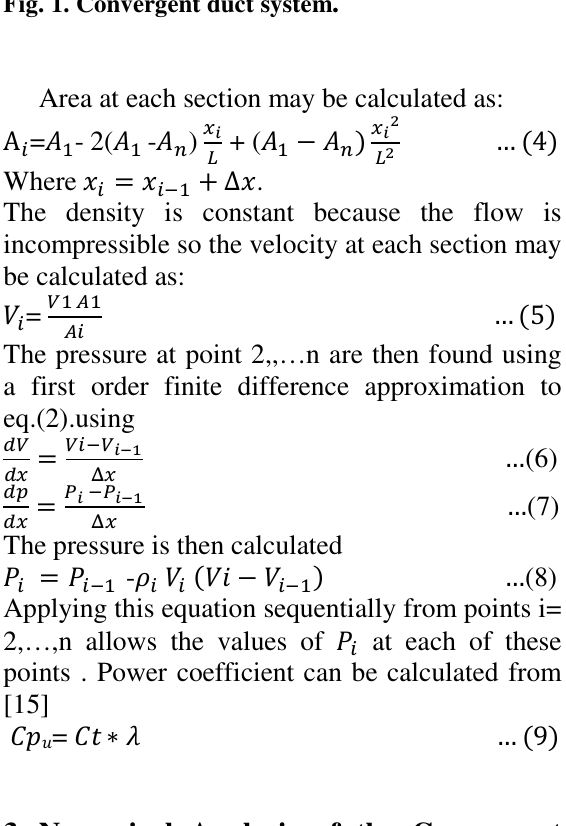
Fig. 1. Convergent duct system